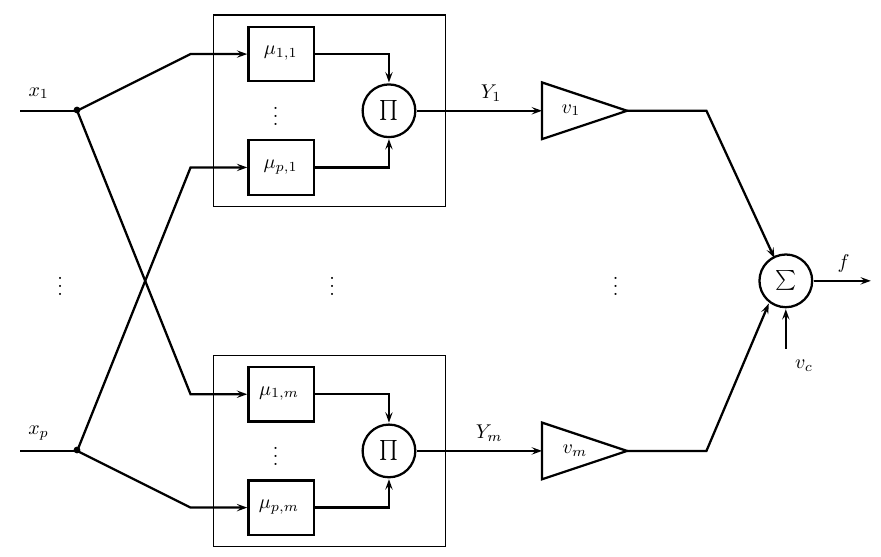
Figure 8. Representation of a compact system with architecture I.